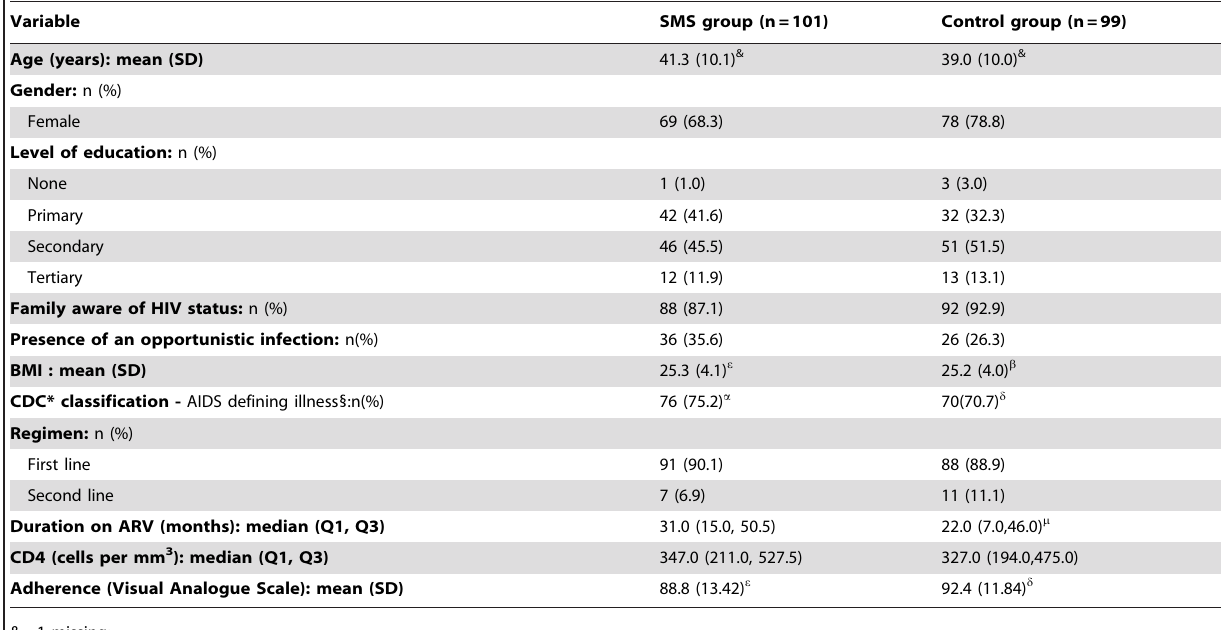
Table 1. Demographics and baseline.